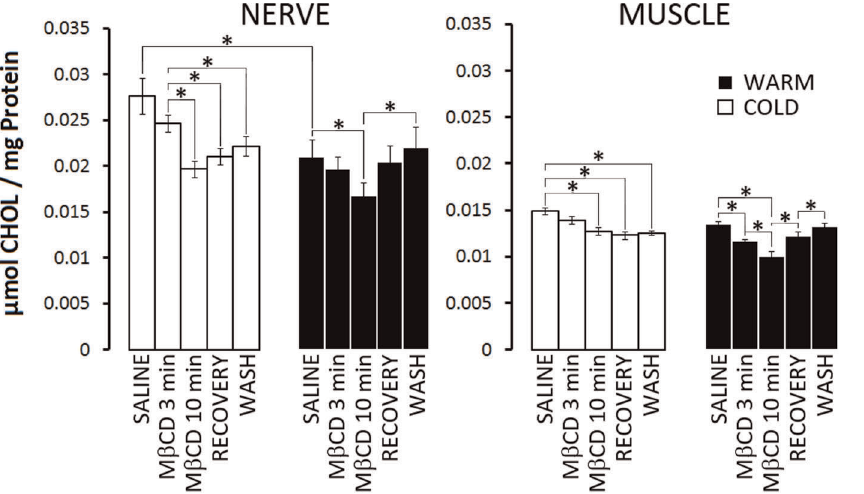
Figure 6. Cholesterol content, depletion, and recovery differ significantly between cold- and warm-acclimatized groups: comparison of isolated nerve and muscle. Cholesterol concentrations were assessed independently in both isolated nerve and muscle tissue. Lipids were extracted separately from isolated nervous tissue (ventral nerve cords from the crayfish abdomen) and isolated muscles. Nerve (left): initial concentrations of cholesterol were significantly reduced in warm- vs. cold-acclimatized animals. Cold-acclimatized group (open bars). Application of 10 mM M b CD caused a significant reduction in cholesterol after 10 min. Attempts to recover cholesterol by perfusion with Ch-HP b CD (recovery) and a saline wash were unsuccessful. Warm-acclimatized group (solid bars). Application of 10 mM MßCD also caused a significant reduction in cholesterol after 10 min. Subsequent perfusion with Ch-HP b CD and saline resulted in recovery of cholesterol to initial levels (i.e. baseline). Muscle (right): initial cholesterol levels were comparable in both the cold- and warm-acclimatized groups. Application of 10 mM M b CD caused a significant reduction in cholesterol after 10 min regardless of the acclimatization condition. Again, attempts to recover cholesterol using Ch- HP b CD and a saline wash were unsuccessful in the cold-acclimatized group. Notably, in the warm-acclimatized group, 3 min exposure to M b CD already resulted in a significant reduction of muscle cholesterol. Perfusion with Ch-HP b CD and saline was sufficient to return cholesterol levels to initial (i.e. baseline) levels in the warm-acclimatized group. N=7.* indicates P ,